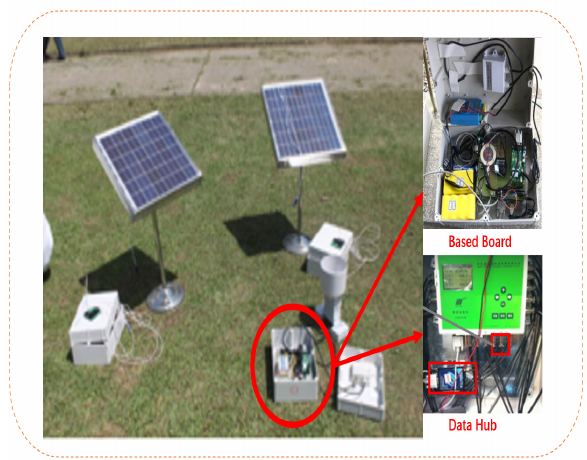
Figure 6. The sensor web with GPRS and Solar